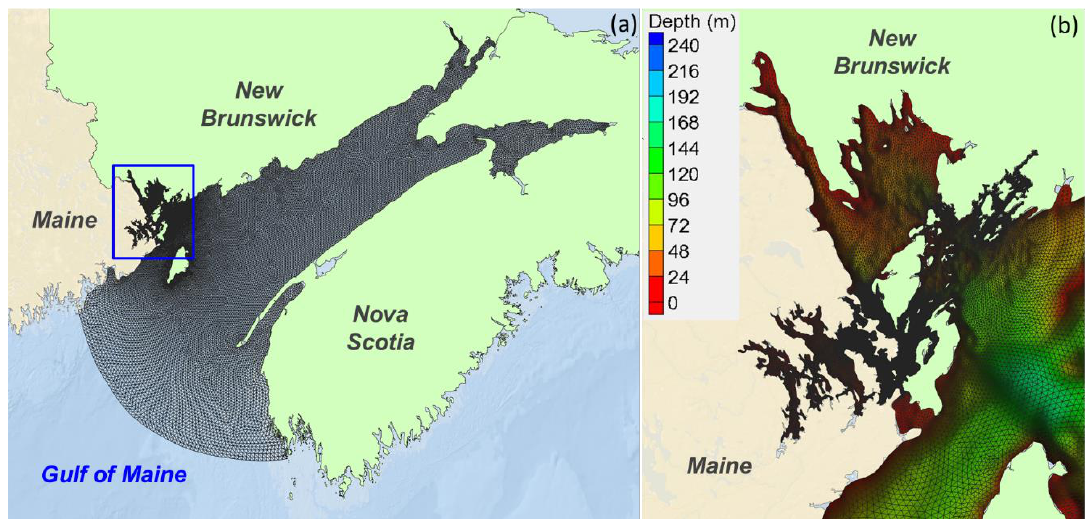
Figure 3. ( a ) Model grid of the finite-volume community ocean model (FVCOM) for the model domain that consists of the Passamaquoddy–Cobscook Bay archipelago (blue box), Bay of Fundy, and northern Gulf of Maine; ( b ) zoomed-in model grid with bathymetry for the Passamaquoddy– Cobscook Bay